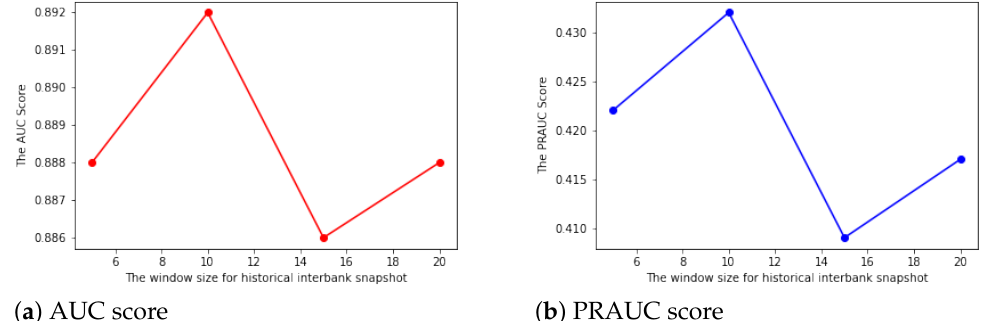
Figure 4. The evaluation metrics with different historical time periods. In ( a , b ), we use the penalty value equal to 4 and 1-hop neighborhood GCN units. We set the window size from 5 to 20, and the performance of AUC and PRAUC scores are shown in ( a , b ).